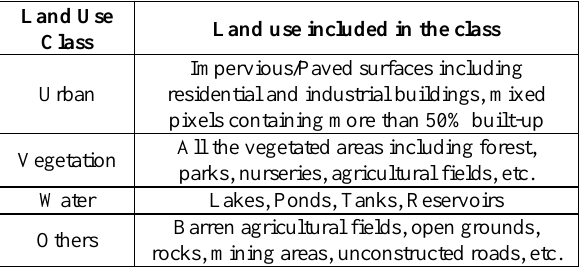
Table 3: Land use classification categories